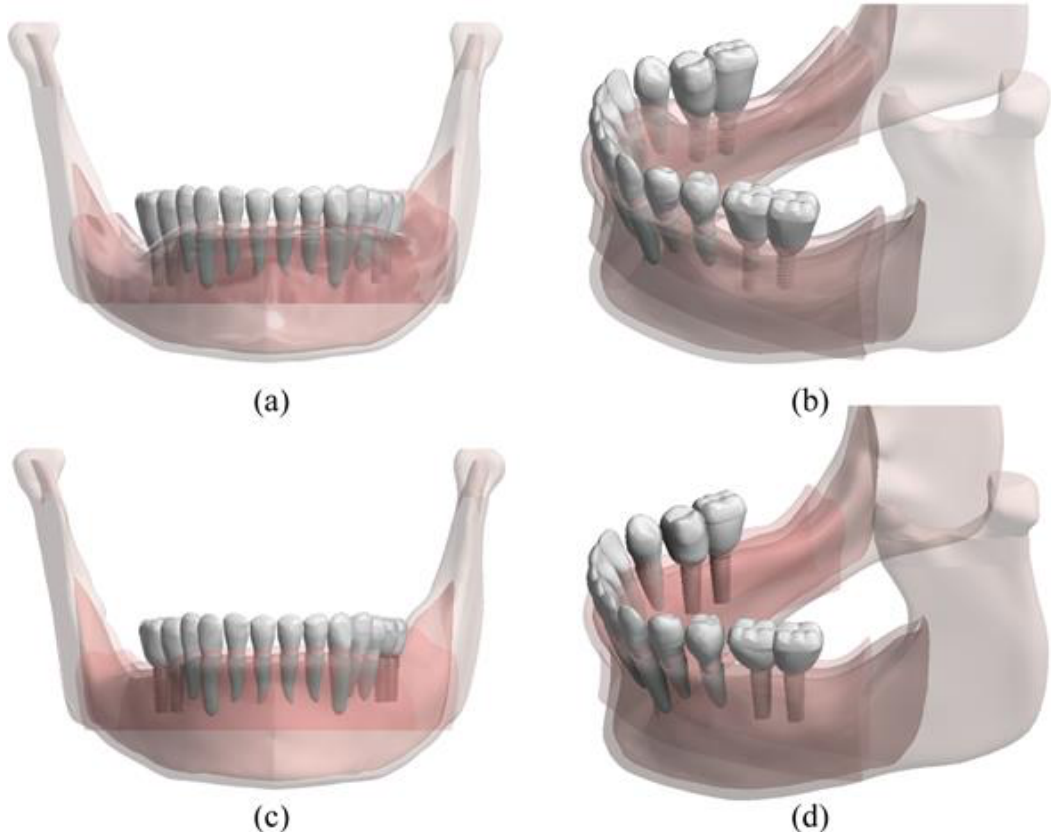
Figure 2. Detailed views of the 3D model of the resorbed and the virtually augmented mandible with modeled implant-supported restorations, remaining dentition, periodontal ligaments, gingiva, cortical, and cancellous bone layers. ( a ) Front view of complete model of the resorbed mandible with placed implant-supported restorations ( b ) Perspective view of complete model of the resorbed mandible with placed implant-supported restorations. ( c ) Front view of complete modeled mandible with simulated bone augmentation and placed implant-supported restorations. ( d ) Perspective view of complete modeled mandible with simulated bone augmentation and placed implant-supported restorations.